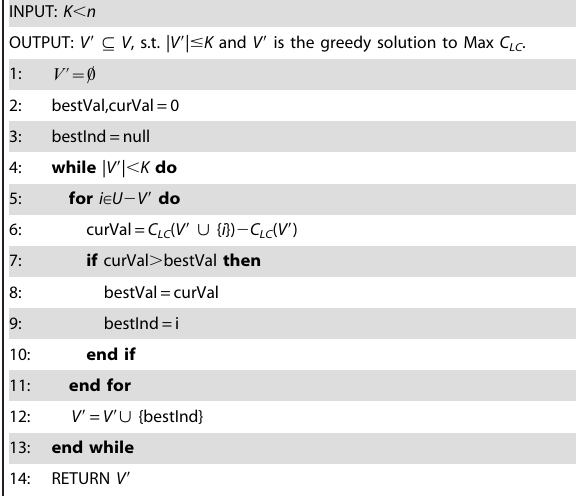
Table 1. Algorithm: GREEDY- C LC .